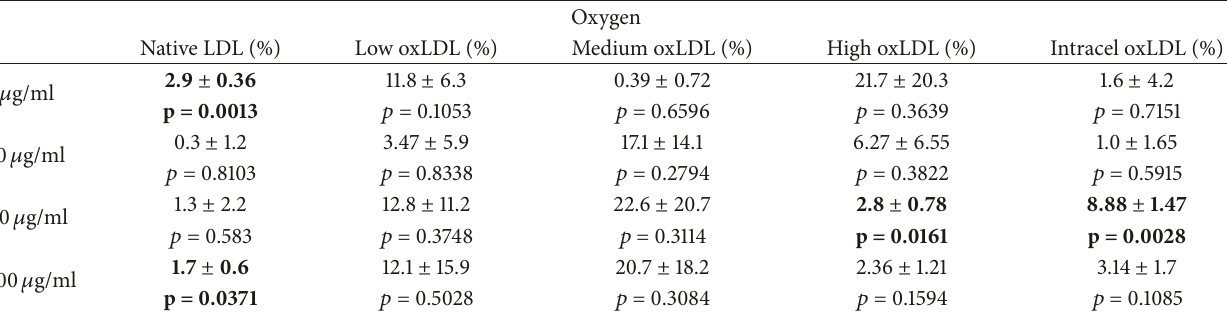
Table 3: Metabolic oxygen consumption of various LDL exposure to macrophages. Mean peak MAMP height changes and standard errors for each experimental condition during exposure. All 𝑝 values are calculated based on peak height versus 10min average basal value prior to exposure. Terms in bold are representative of 𝑝 < 0.05 , indicating statistical